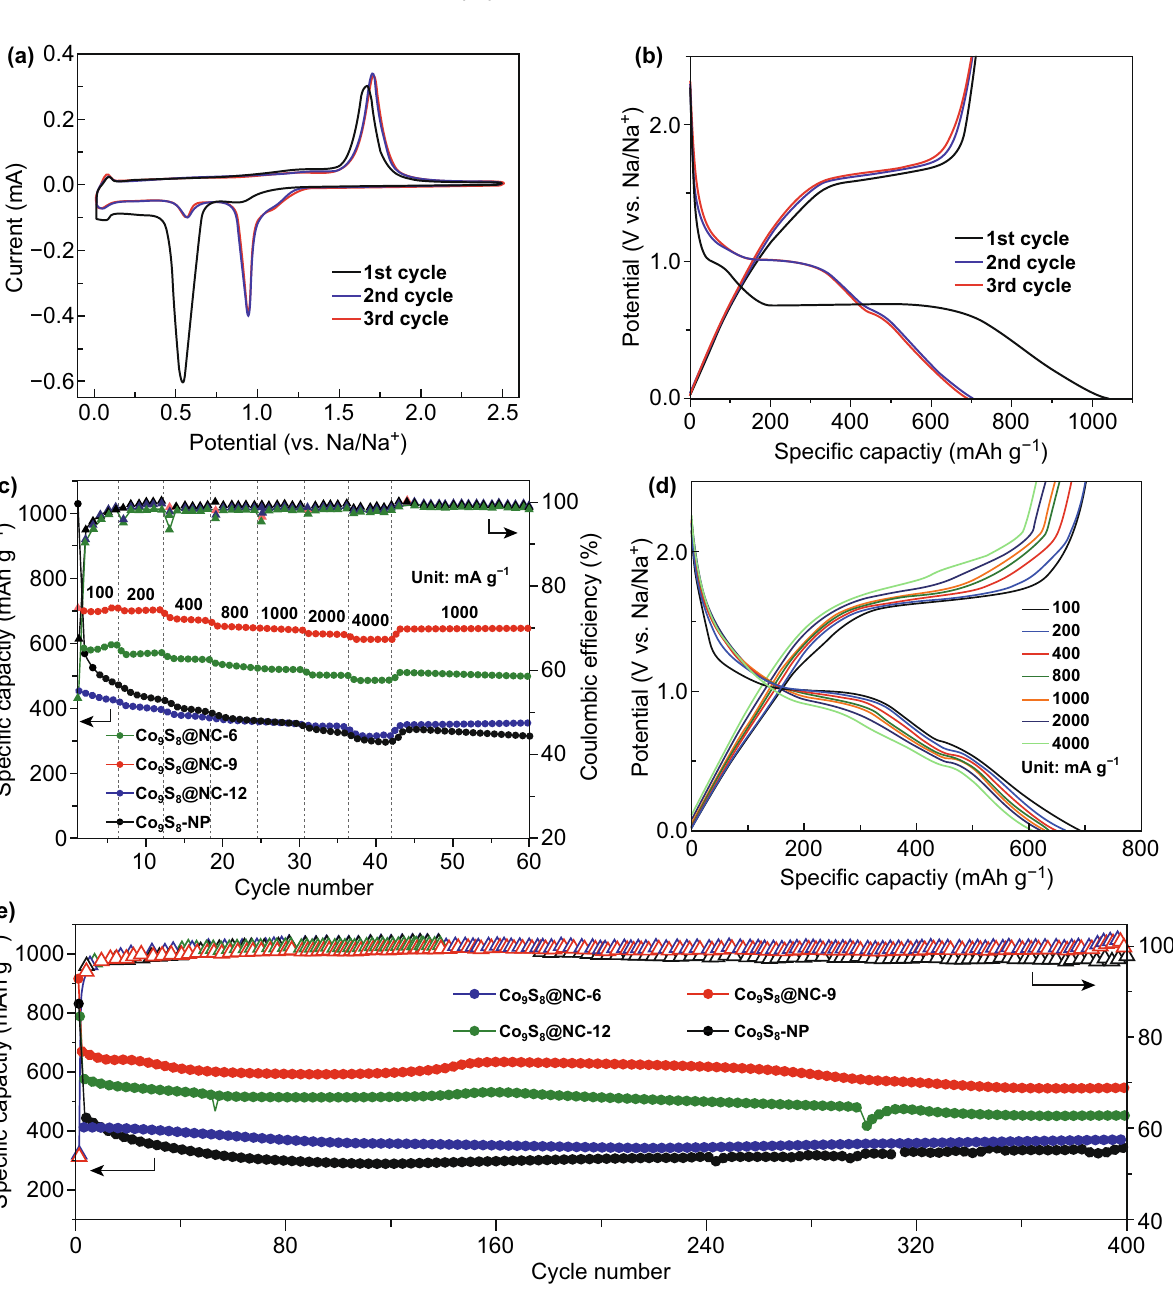
Fig. 3 Electrochemical performance of the Co 9 S 8 @NC electrodes. a CV profiles of Co 9 S 8 @NC-9 electrode for the initial three cycles. b Galva- nostatic discharge–charge profiles of